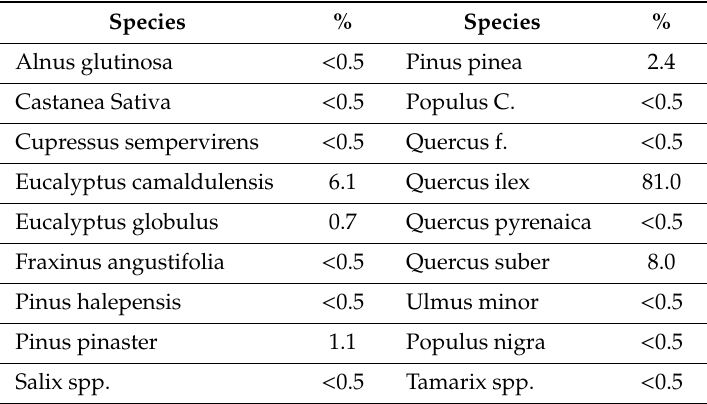
Table 1. Distribution of forest species according to the